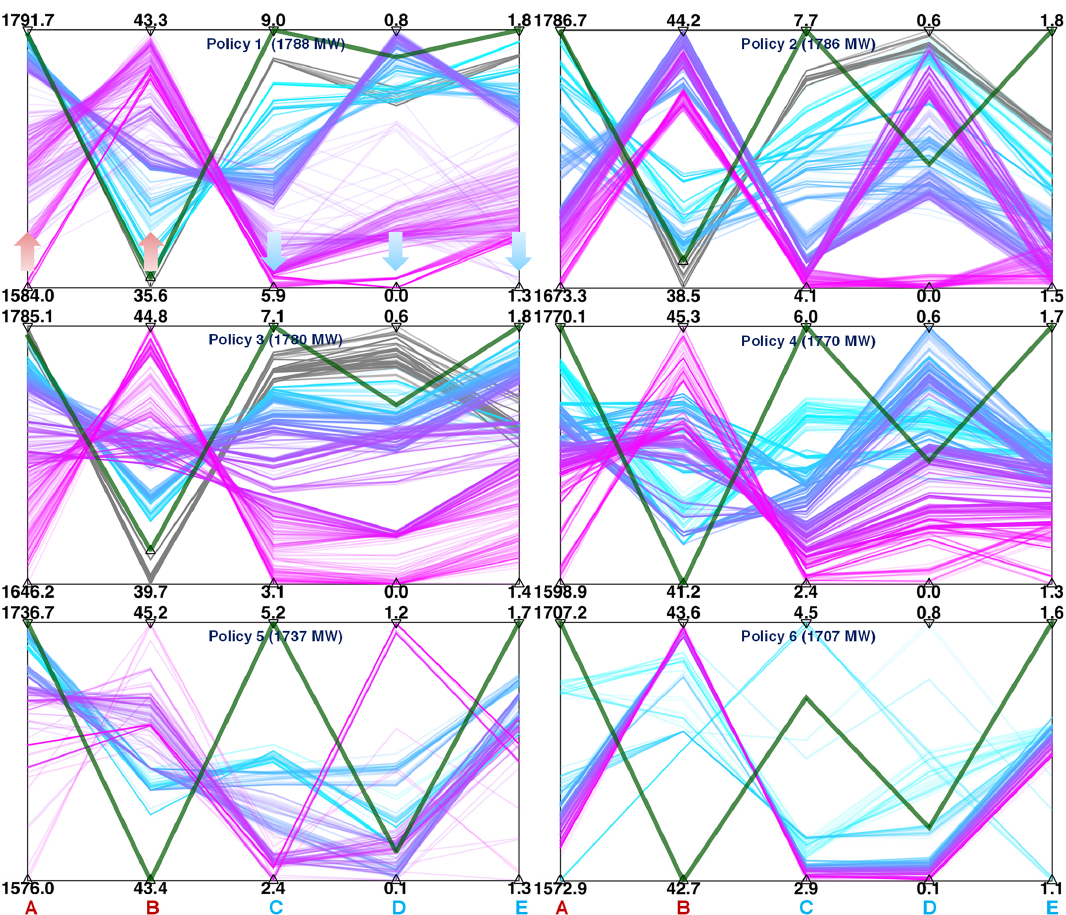
Figure A3. Parallel plots of multiple objectives (A – mean output, MW; B – 10th percentile of annual water release, BCM; C – standard deviation in annual water release, BCM; D – spillage loss, BCM per year; E – evaporation loss, BCM per year) of each policy corresponding to the Pareto fronts in Fig. 9. The bold green line refers to the reservoir operation without the drought policy.